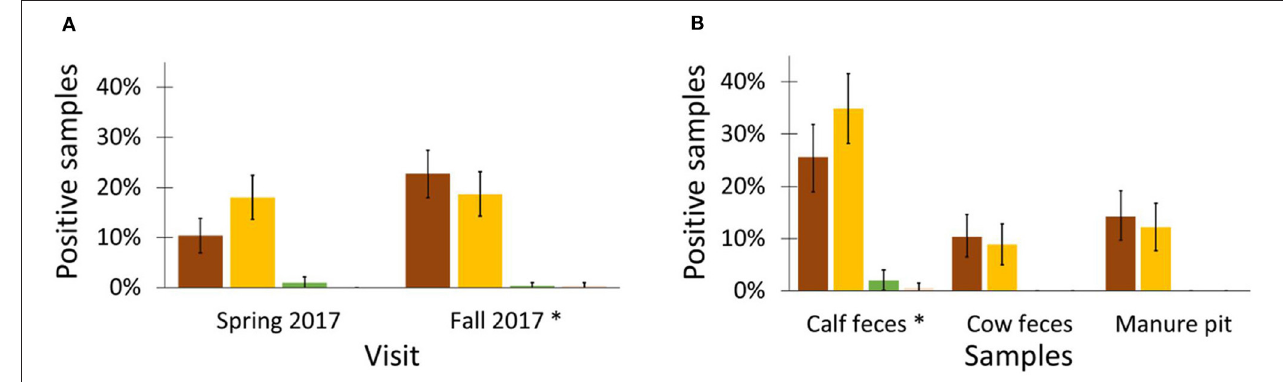
FIGURE 5 | Distribution of phenotype ESBL ( ), AmpC ( ), ESBL + AmpC ( ), or other ( ) in Escherichia coli isolated from calves, cow and manure pits from 101 dairy farms from Québec Province, Canada . (A) Distribution of phenotypes by sampling seasons (B) Distribution of phenotypes by origin of sampling. * p < 0.05 Poisson distribution with Tukey-kramer correction for multiple